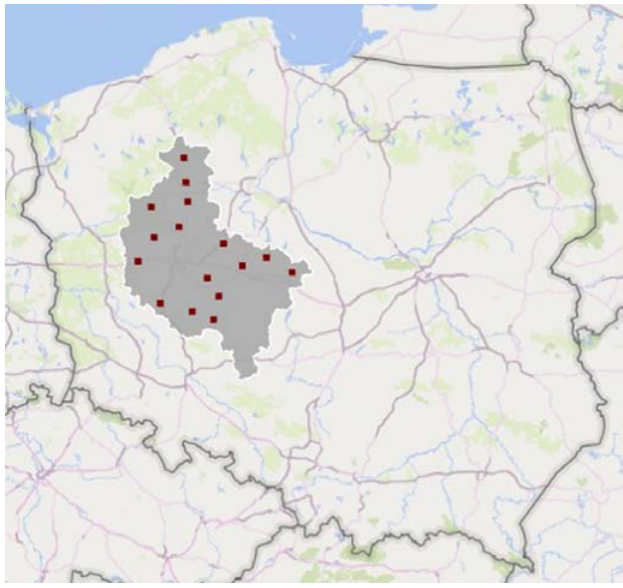
Figure 1. The location of the studied farms in the Wielkopolska region (Poland).